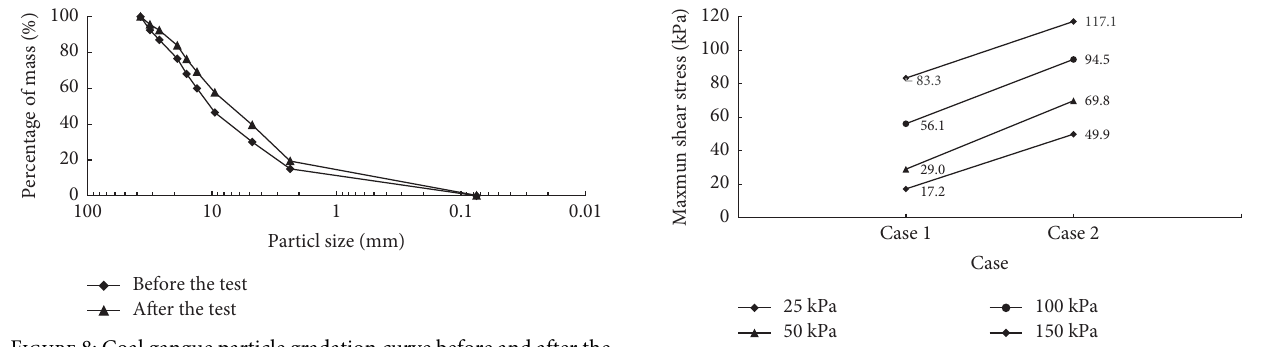
Figure 9: Variation of the maximum shear